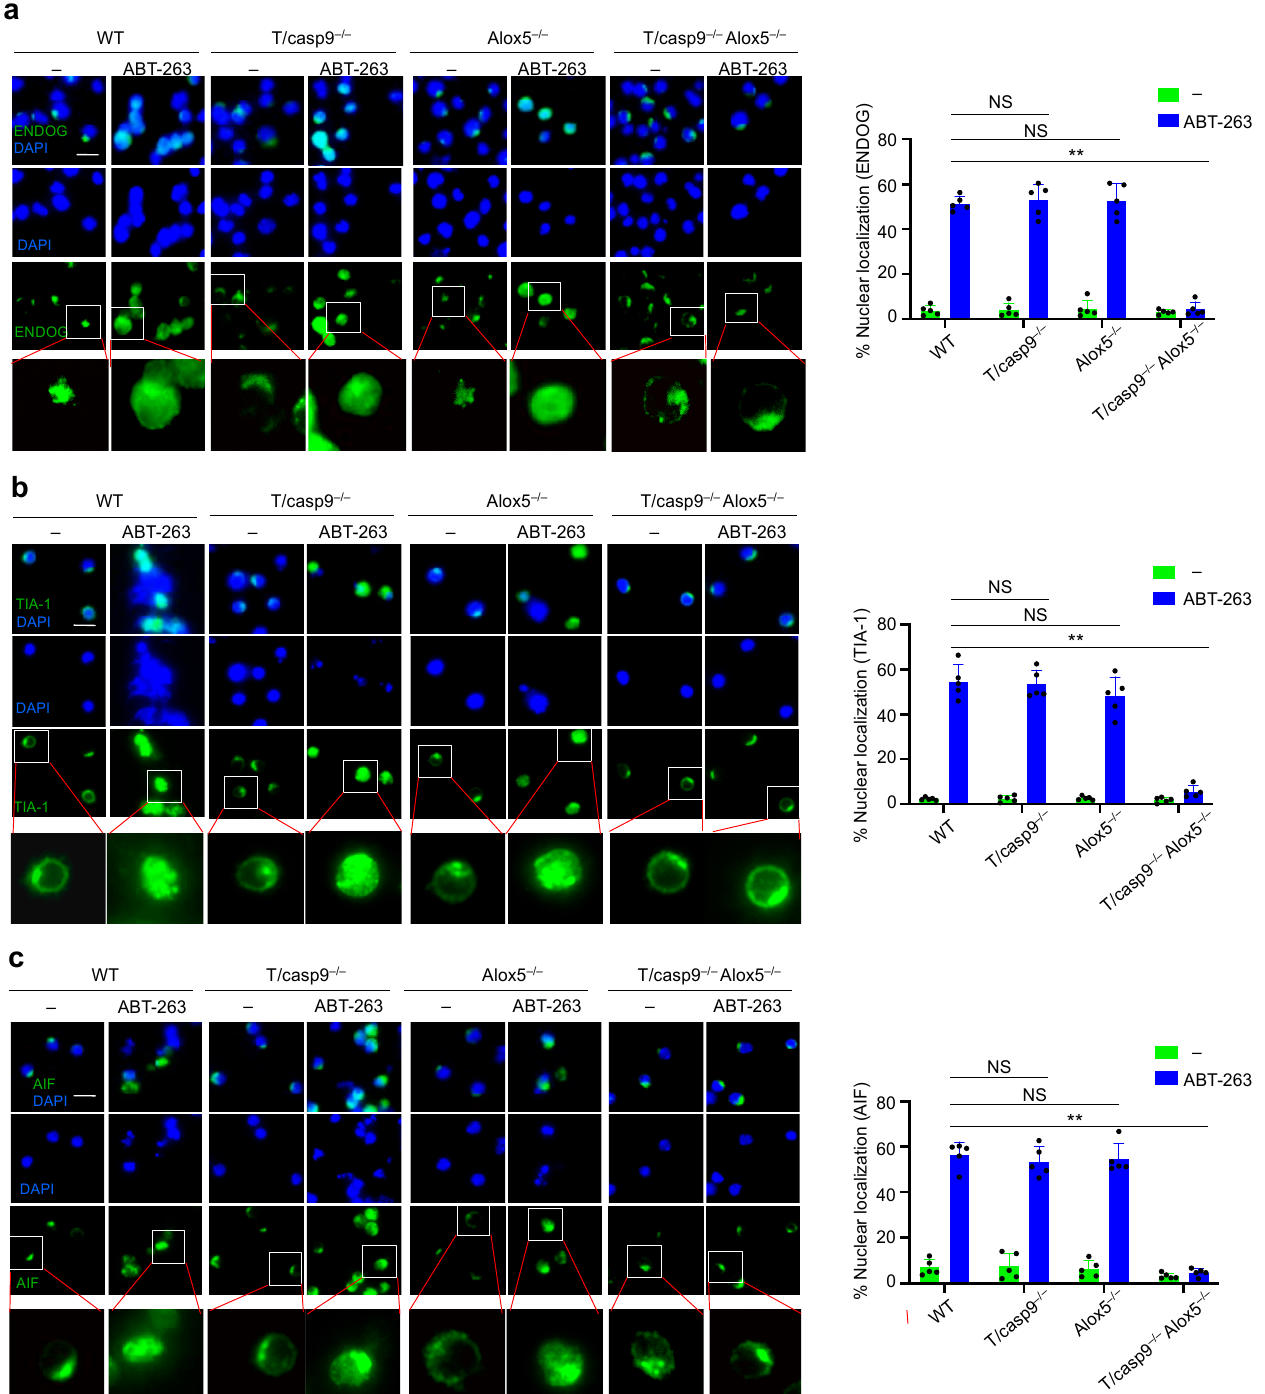
Figure 9. Regulation of nuclear translocation of nucleases and cytolytic molecules by Alox5. T cells cultured as in Figure 8b were treated with ABT-263 for 12 h. The cells were used for immunocyto- chemistry staining of ( a ) EndoG, ( b ) TIA-1 or ( c ) AIF. The nuclei were counterstained with DAPI. Scale bar: 10 μ m. Comparison to wild-type control: NS, statistically not significant; ** p < 0.01.